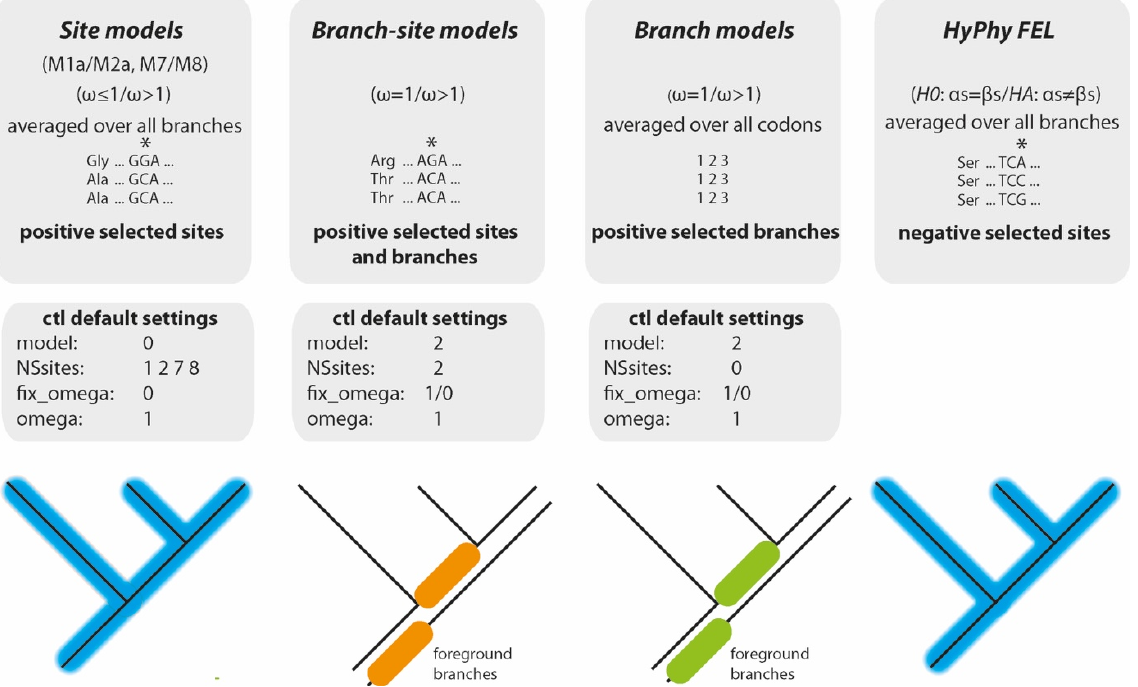
Figure 2. Phylogenetic scope of different tests. The site models and HyPhy FEL calculate significant (*) positively and negatively selected sites, respectively, averaged over all branches (labelled blue). The branch-site models combine site-specific and branch-specific positive selection analyses for all possible foreground branches (two are labelled orange). The branch models use all possible foreground branches (two are labelled green) to calculate the average ω over all codons (labelled 1 2 3 codon positions). The default settings for the codeml ctl files are given below the corresponding models.